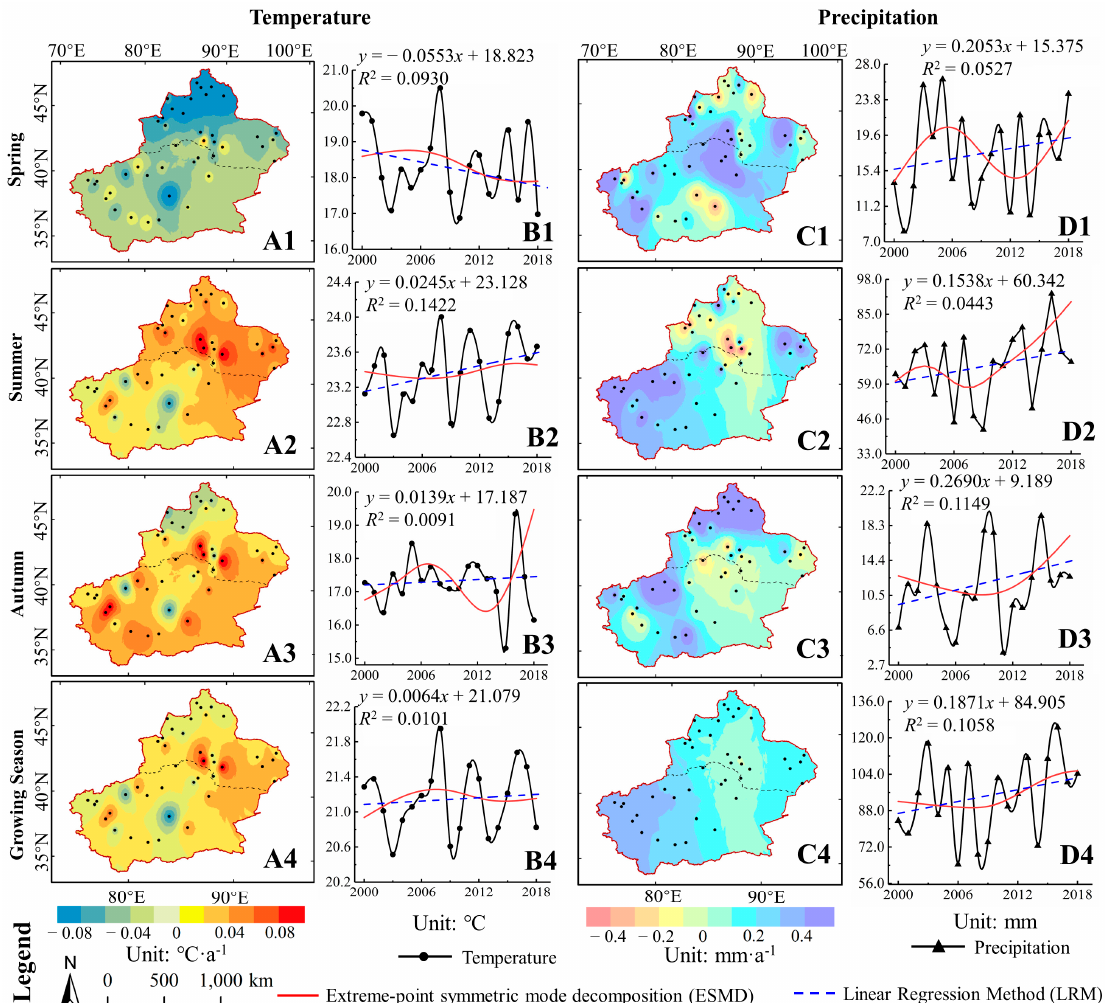
Figure 4. Spatial-temporal change for temperature and precipitation in Xinjiang during 2000–2018. ( A , C ) denote the spatial pattern for the change of temperature and precipitation, respectively. ( B , D ) are the interannual variations and the trends of temperature and precipitation, respectively. 1~4 denotes the in spring, summer, autumn, and the growing season, respectively. However, the spatial variation of precipitation are different in different seasons.